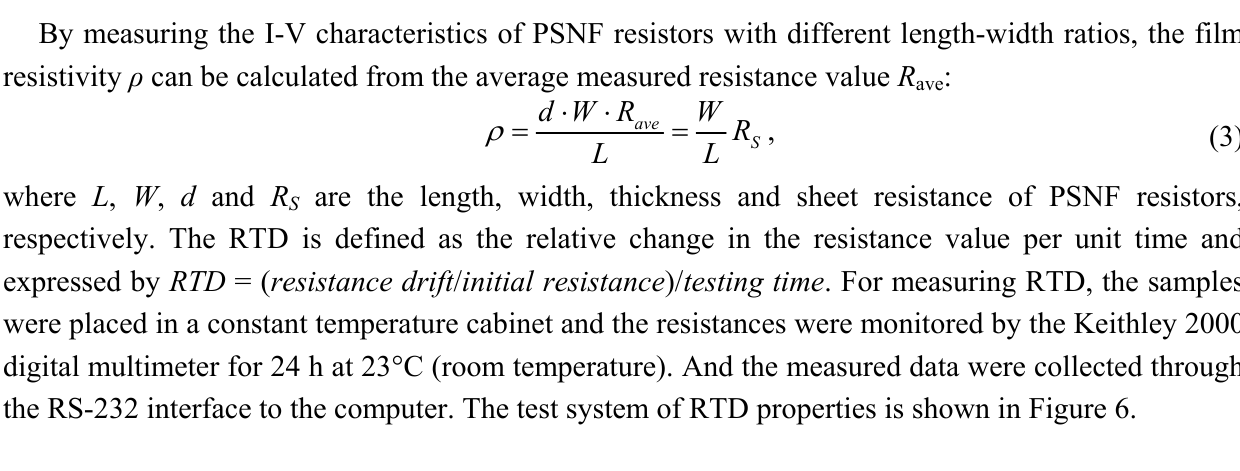
Figure 6. Test system of RTD